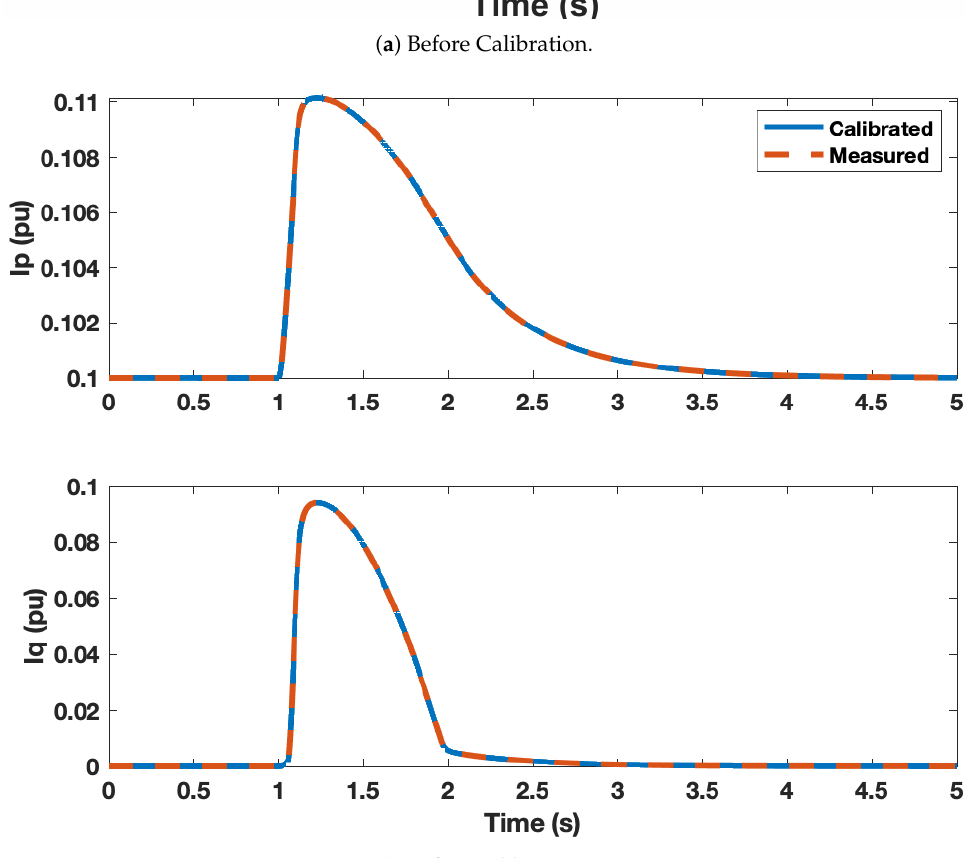
Figure 7. Measurements vs. model response ( a ) before and ( b ) after